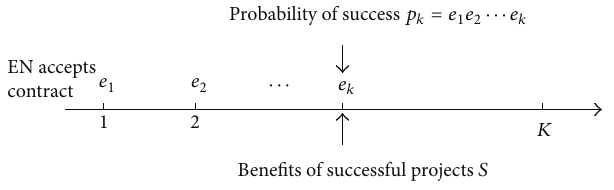
Figure 2: Success after 𝑘